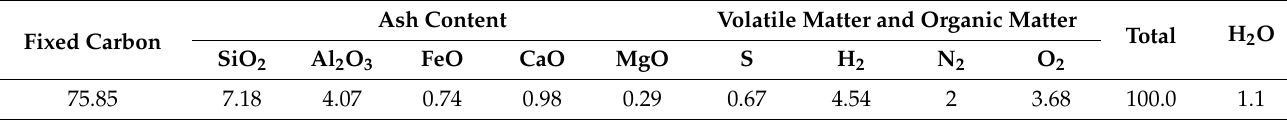
Table A8. PCI composition for calculation (mass%).